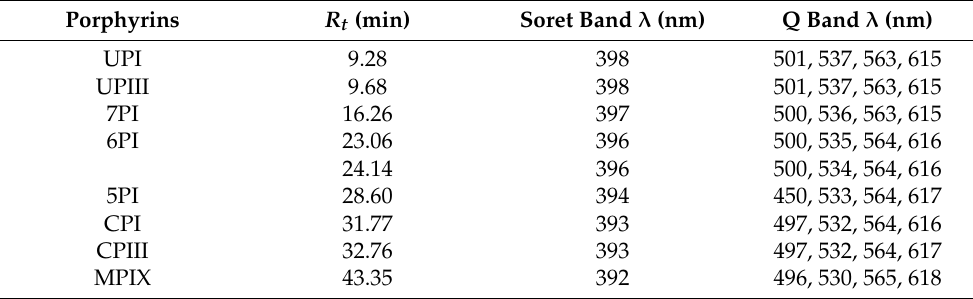
Table 1. Chromatographic and spectral properties of porphyrin standards.